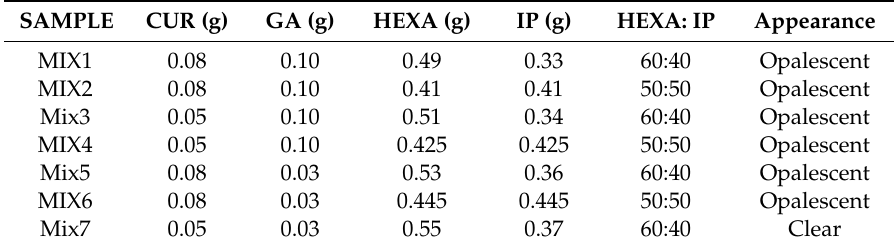
Table 1. Composition of lipid mixtures.